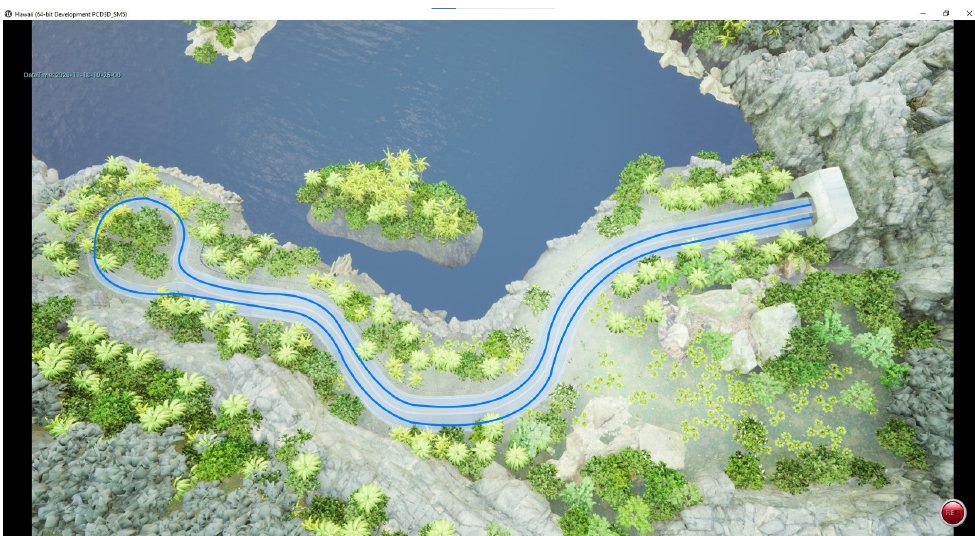
Figure 15. The trajectory of the testing path of the